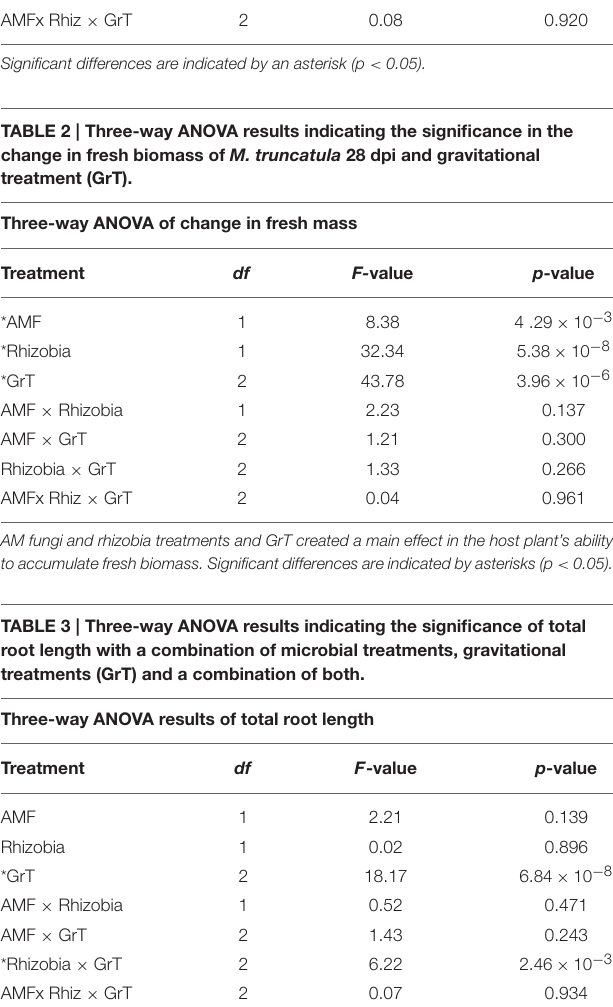
TABLE 2 | Three-way ANOVA results indicating the significance in the change in fresh biomass of M. truncatula 28 dpi and gravitational treatment (GrT).